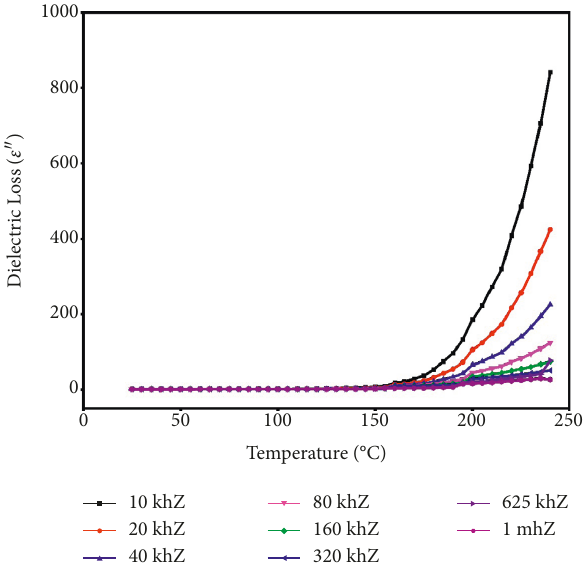
Figure 10: Dielectric loss spectrum of the methyl orange dye- doped K 2 SO 4 single